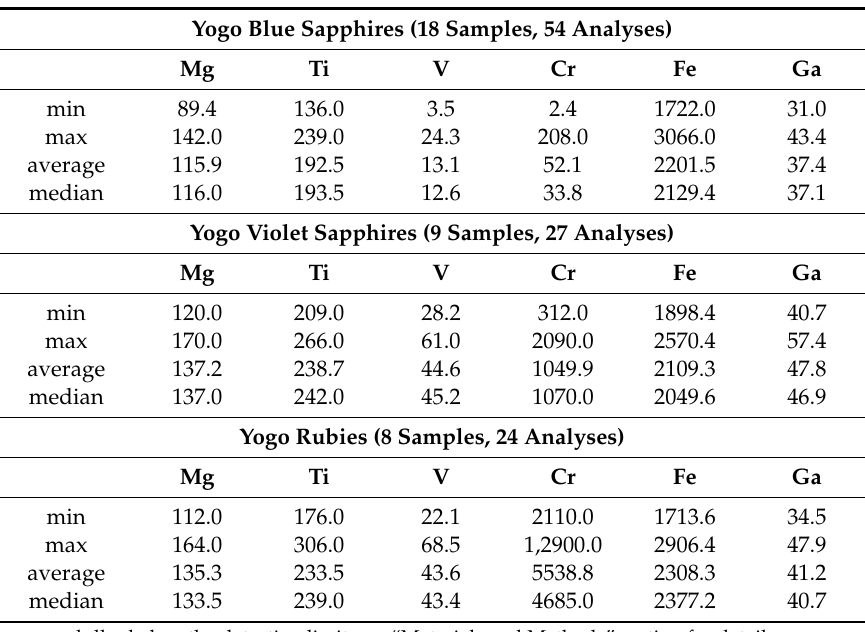
Table 10. Summary of trace elements for Yogo sapphires and rubies in ppm.